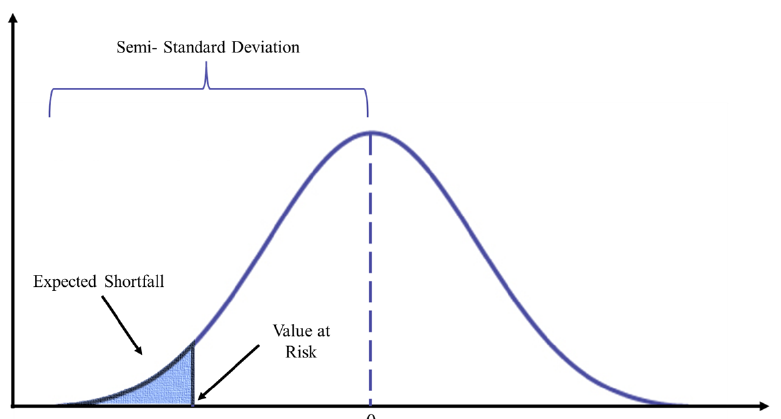
Figure 1. Probability density function of risks and measures of hedging effectiveness.